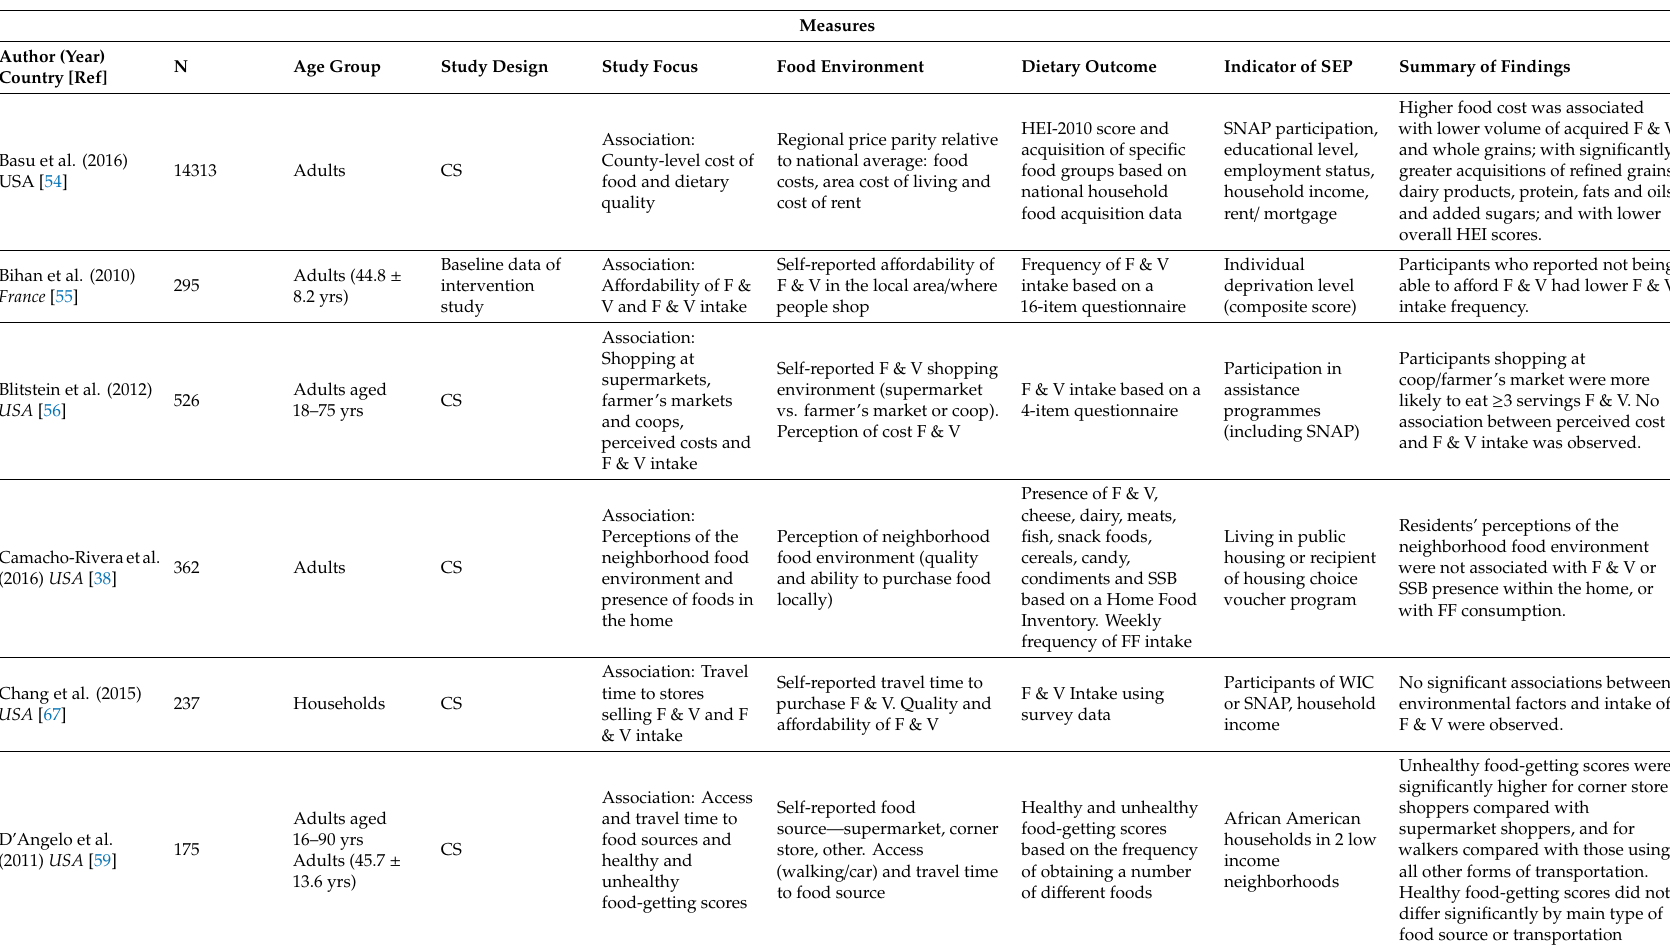
Table 3. Overview of included studies reporting on associations between aspects of the food environment and diet in a single socioeconomic group – in alphabetical